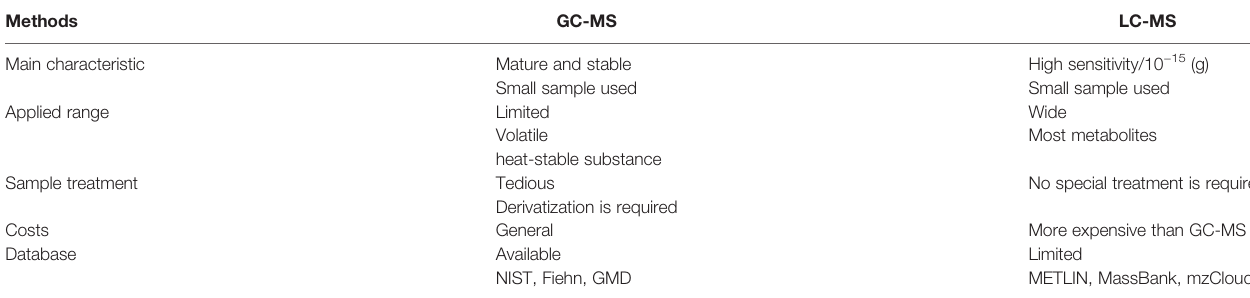
TABLE 1 | The characteristics of GC-MS and